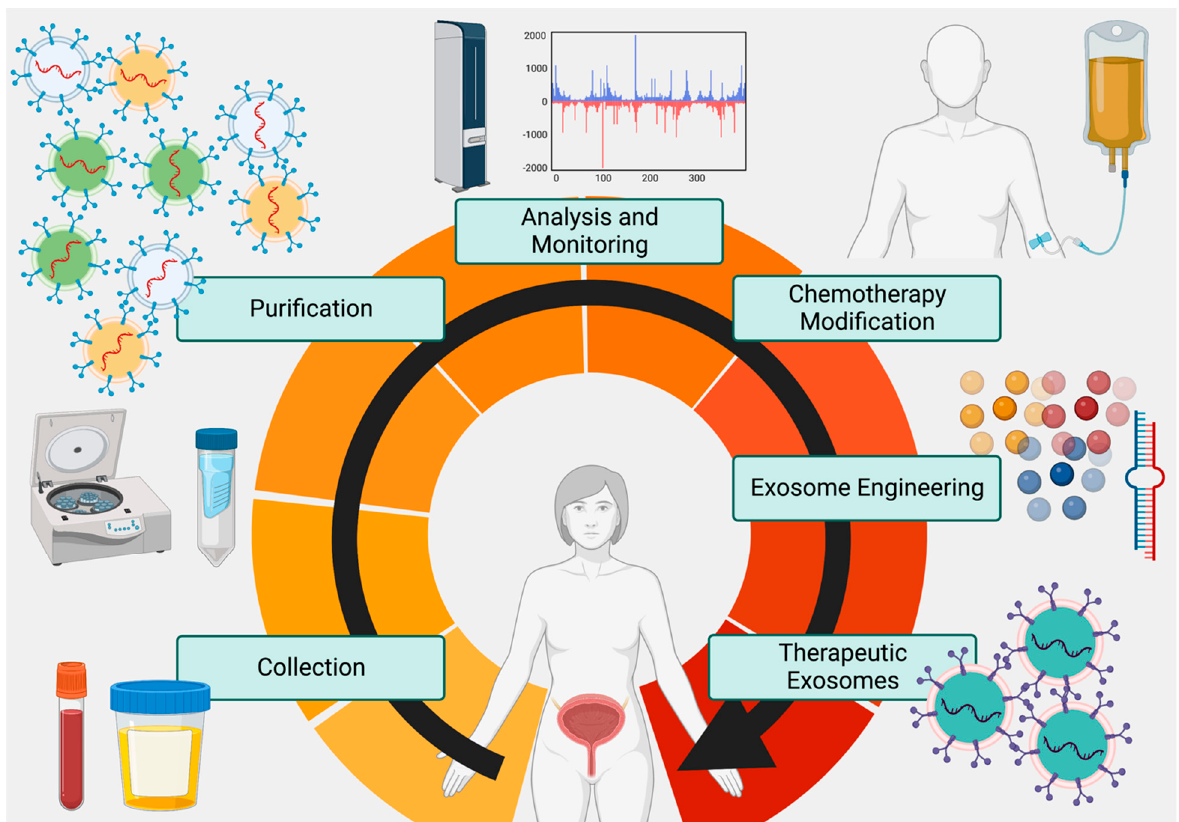
Figure 2. The Proposed Exosome Cycle. Tumor exosomes can be frequently collected from urine and blood, purified in high volumes, analyzed via -omics technology, and used to evaluate both tumor metabolism and response to therapy. In addition to customizing therapy based on exosome analysis, exosomes engineered to deliver custom payloads to tumor cells to promote chemoradiation susceptibility and apoptosis can be used as a synergistic adjunct to surgery and chemoradiation therapies. Created at